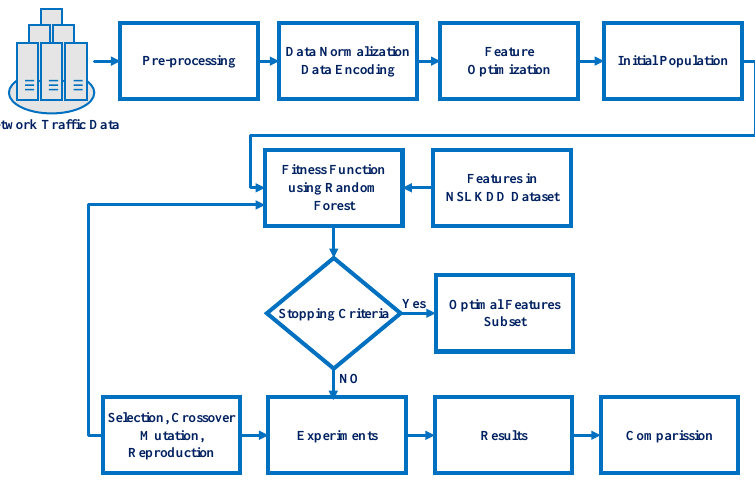
Figure 1. Proposed algorithm